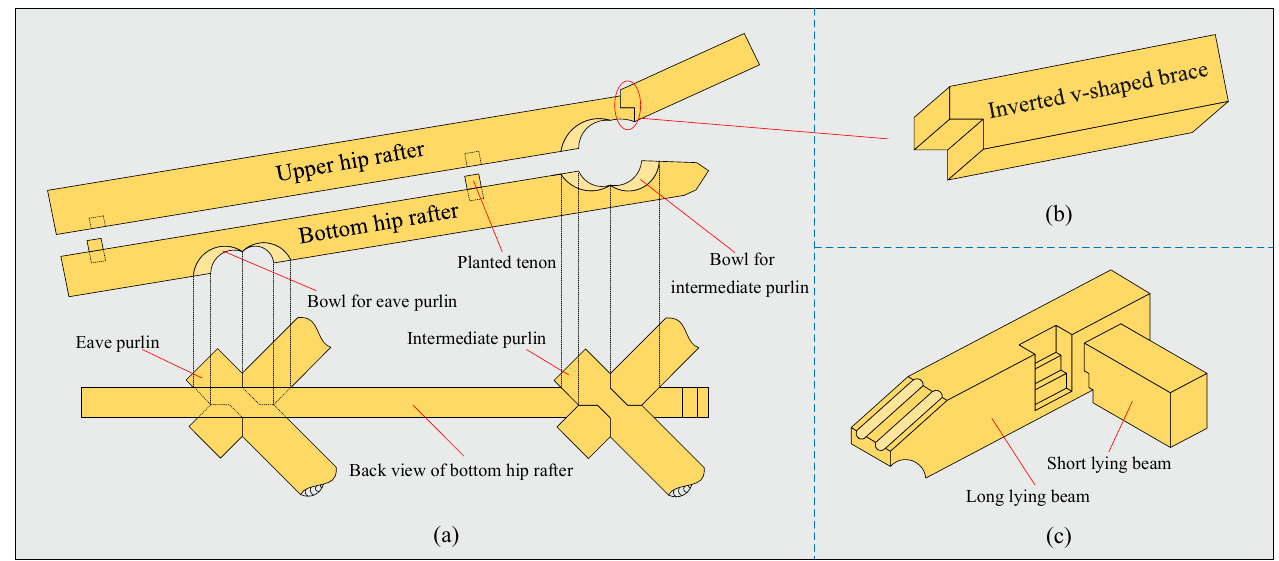
Figure 7. Tenon–mortise joints for overlapping or semi-overlapping horizontal or inclined structural components. ( a ) Bowl for purlin; ( b ) Tenon at the beam end; ( c ) Stepped tenon on the beam.